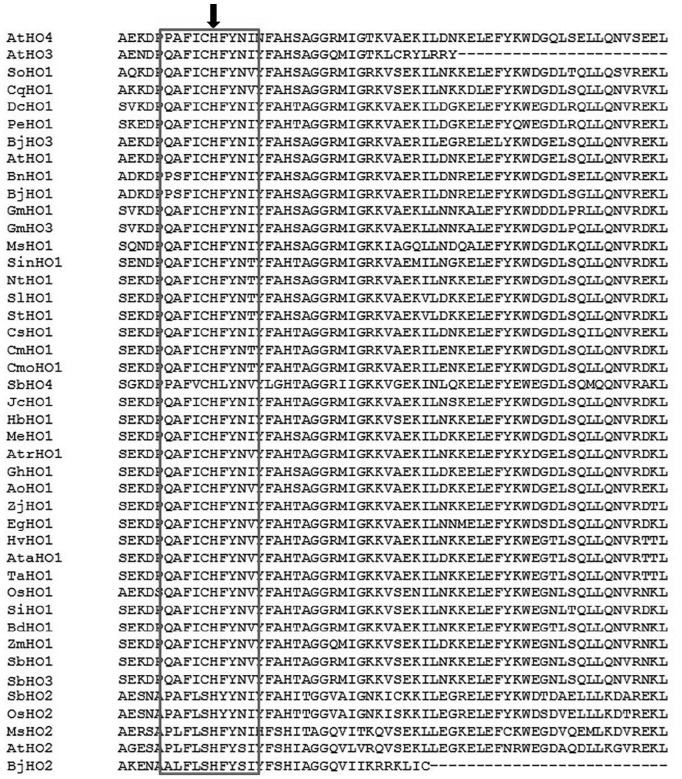
Multiple sequence alignment of SbHO genes and other HO orthologs in plant species. The conserved HO amino acids are emphasized with a red block. The black arrow pointing downward indicates the conserved histidine residue for protein stability. Species included in this analysis are the same as those analyzed in the gene structure with addition to Medicago sativa (MsHO1 and MsHO2), Brassica juncea (BjHO1, BjHO2, and BjHO3), Triticum aestivum (TaHO1), and Hordeum vulgare (HvHO1).